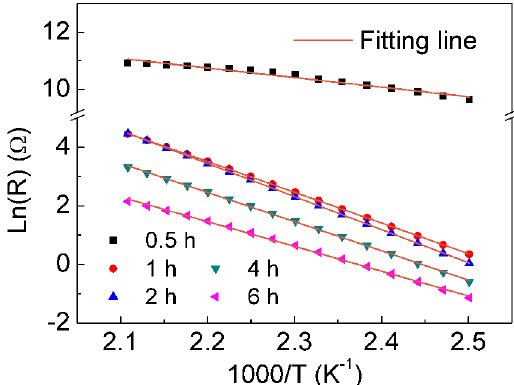
Figure 5. Arrhenius plots of lnR against 10 3 /T for BTN samples were reoxidized at 800ºC for 1 h after sintering at 1190 ºC for different time.